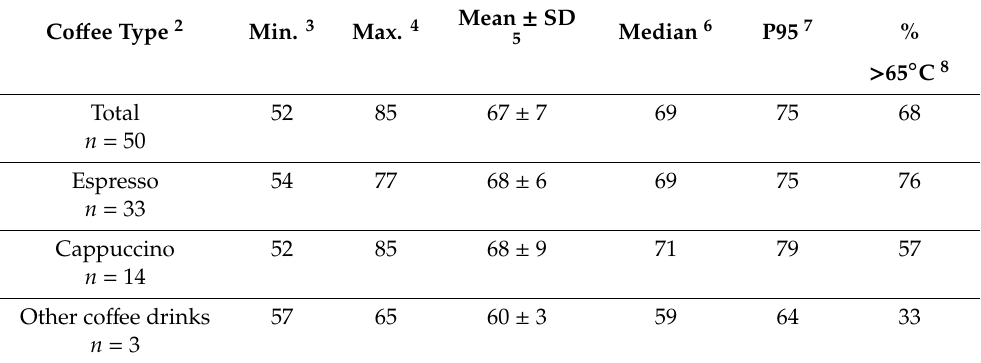
Table2. Summarizedresultsofbestsellers’servingtemperatures( ◦ C)in50co ff eeshops(CS),accordingto co ff ee type 1